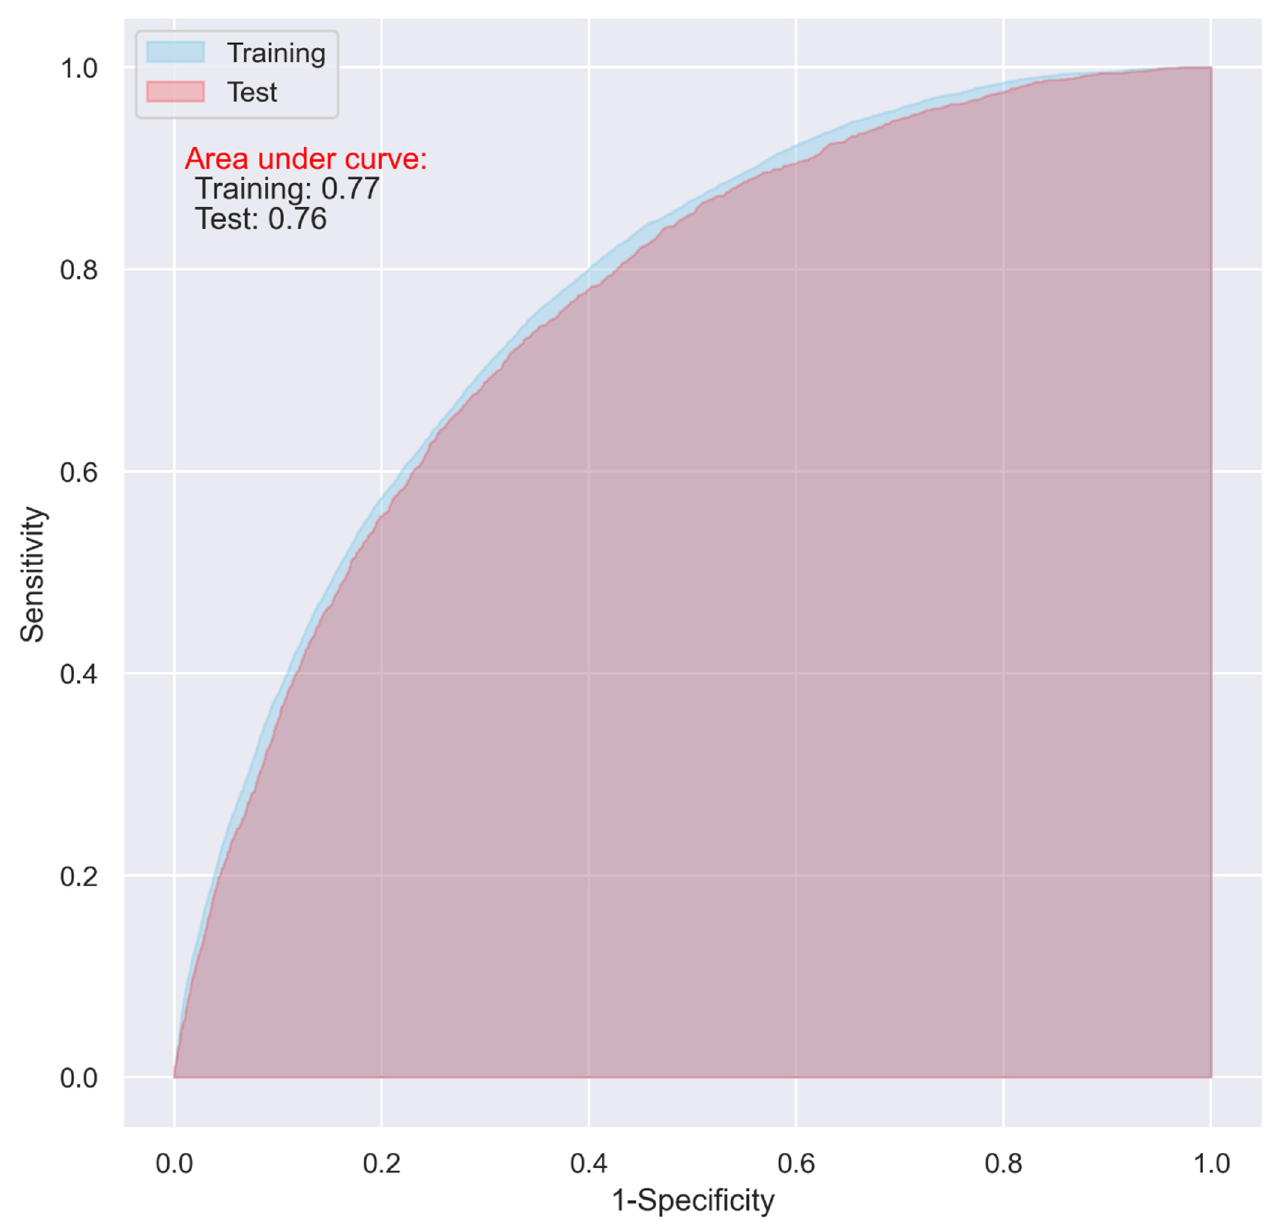
Figure 5. ROC of the CNN model including the variables with a relative importance of >0.05 in the stepwised LR model.